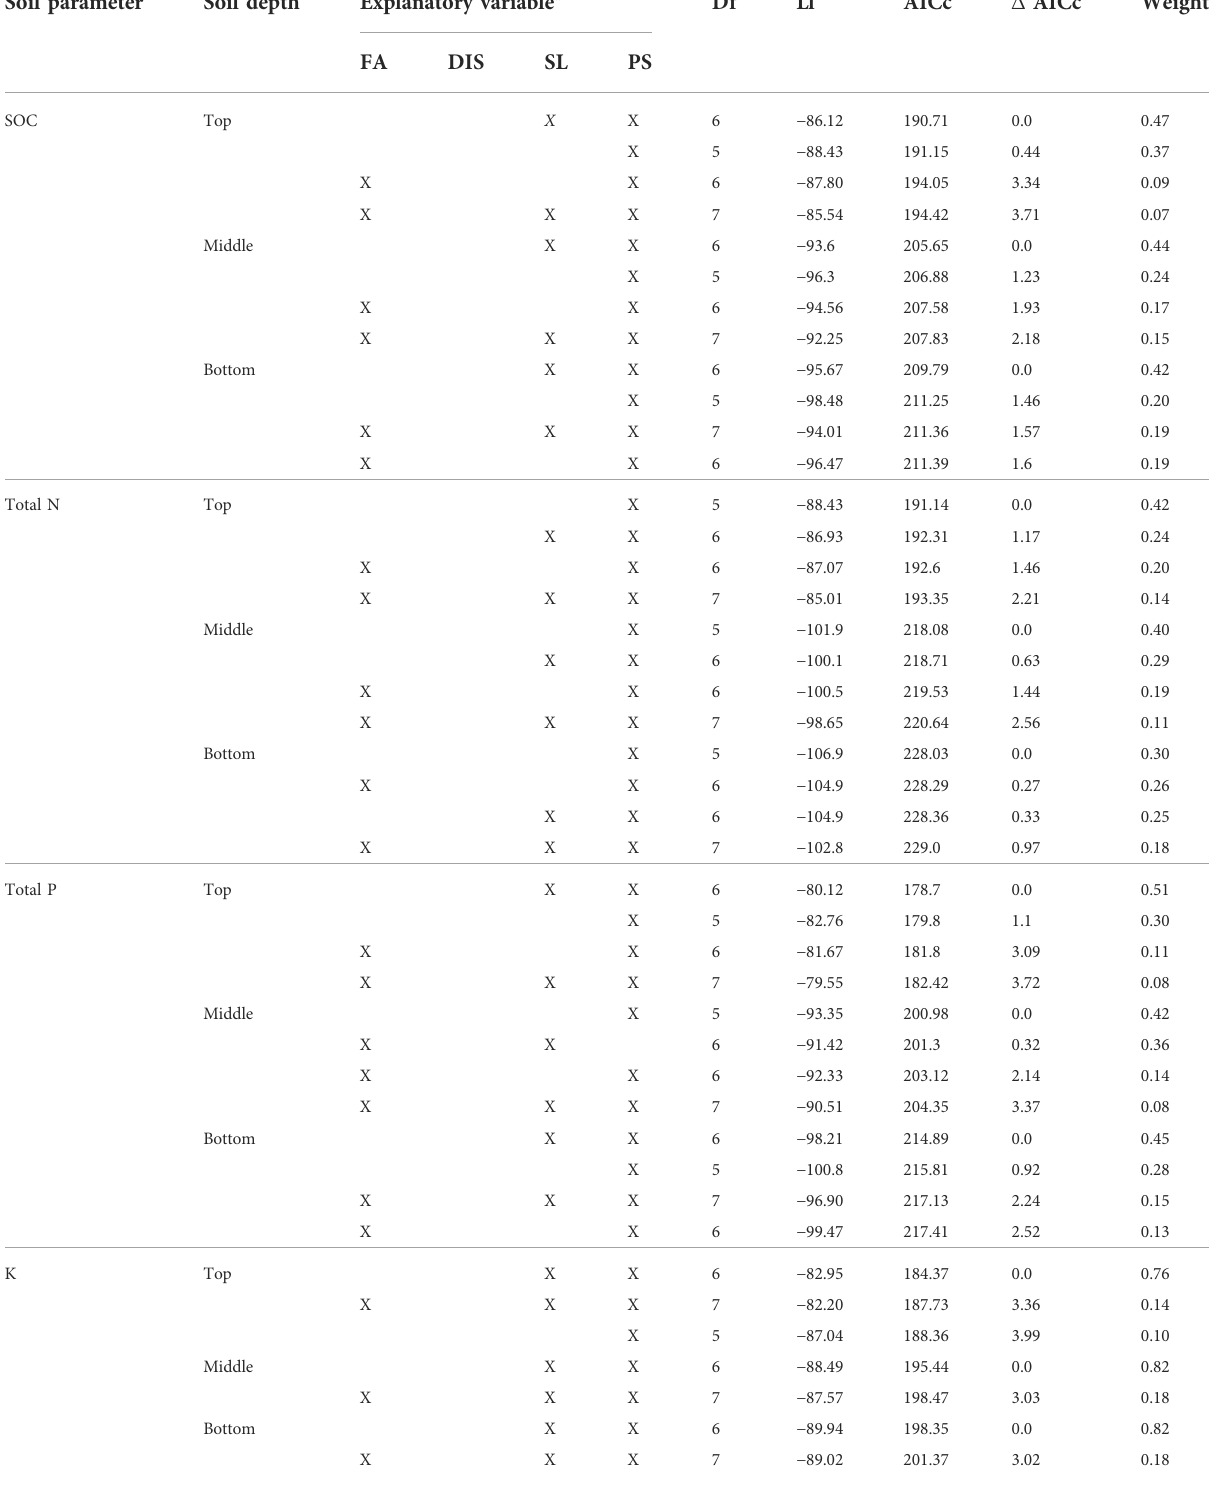
TABLE 4 Summary of LMEM between soil C and nutrient recovery with environmental attributes obtained using the package MuMin. Where, DF — Degree of Freedom, LL — Log Likelihood, AICc — Akaike Information Criterion corrected for small sample size. Soil parameter